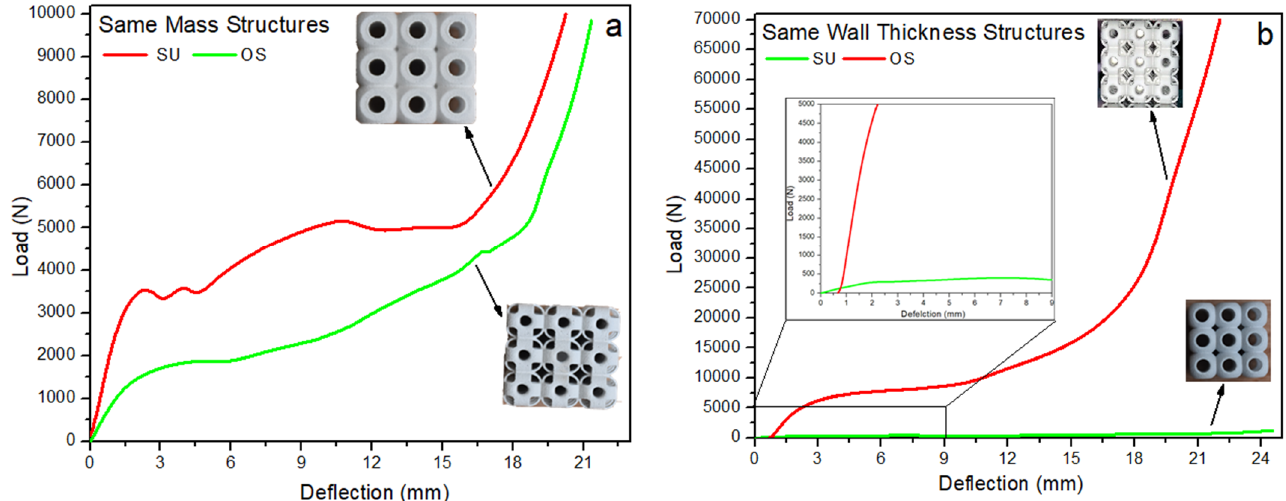
Figure 5. Compressive performance of both 3 × 3 × 3 structures under uniaxial load, ( a ) structure with same relative densities, ( b ) structure with the same wall thickness with an enlarged view of minimum.